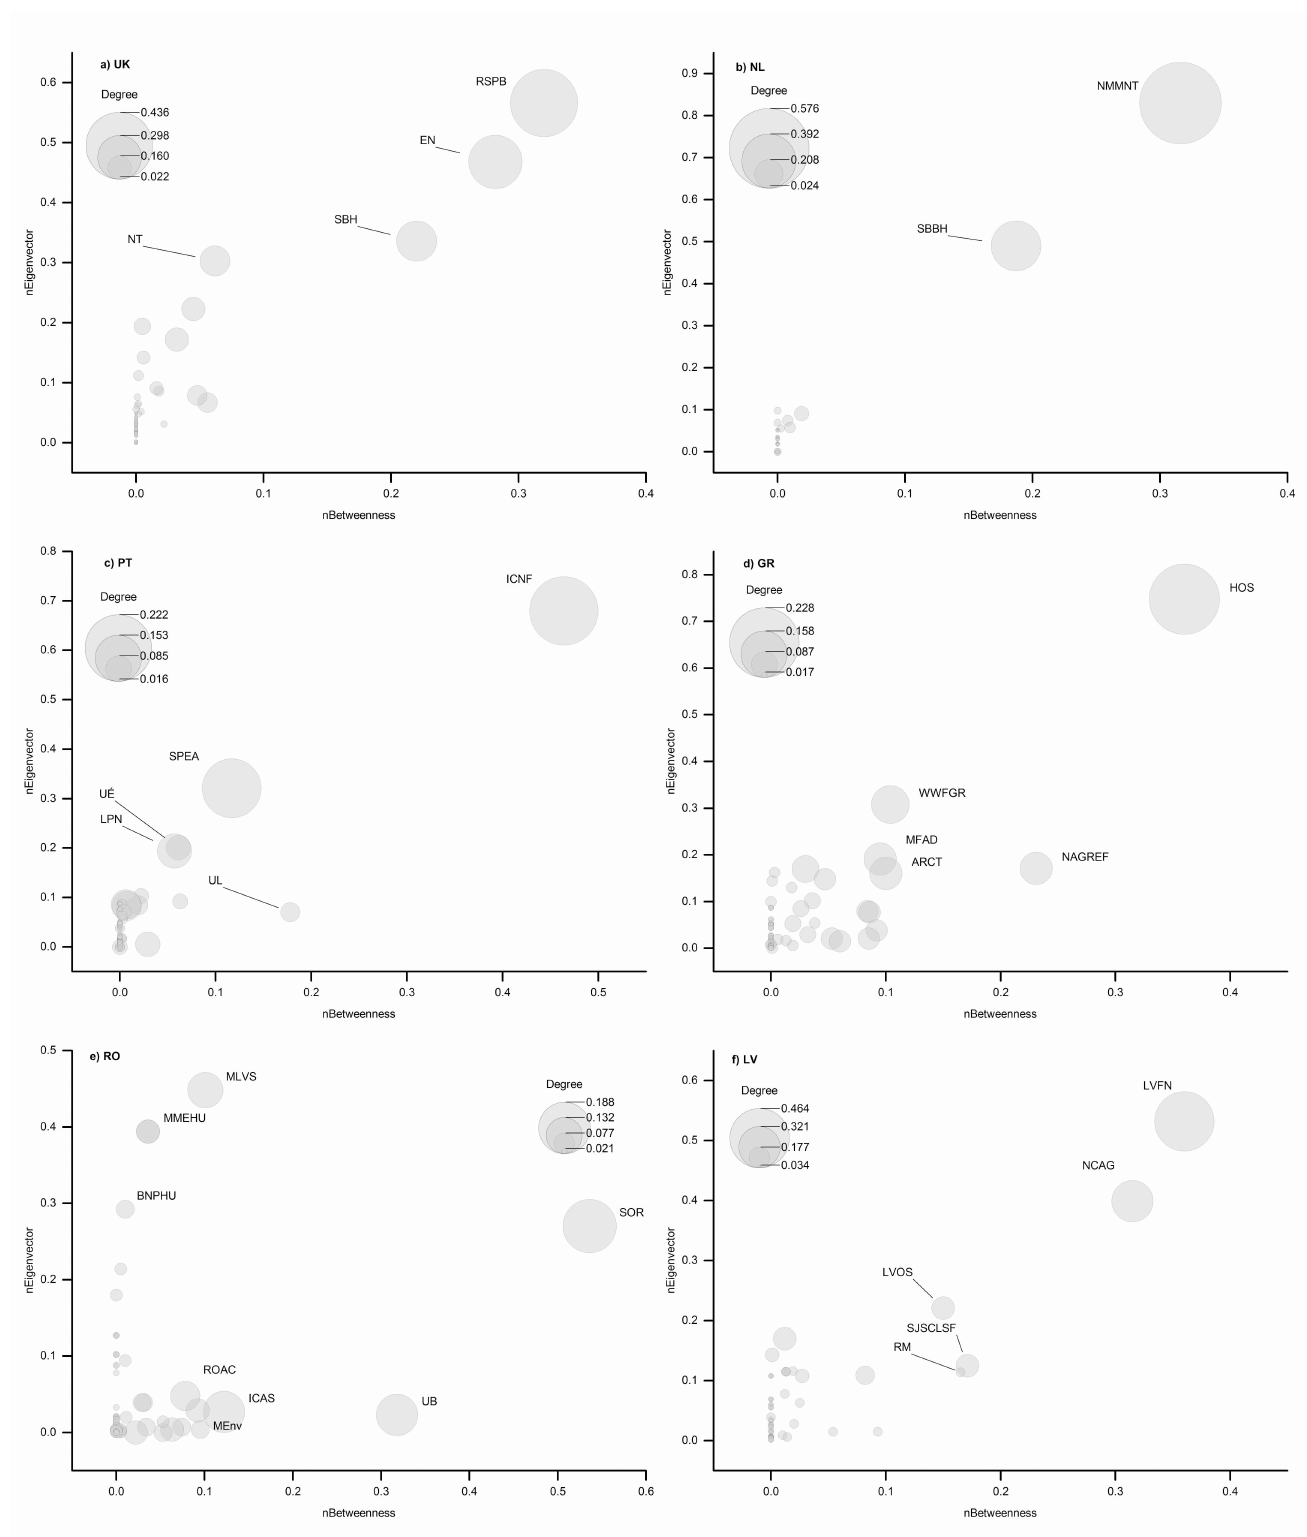
Fig 3. Betweenness vs. Eigenvector centrality for United Kingdom, Netherlands, Portugal, Greece, Romania and Latvia (abbreviations are shown in S4 Table).